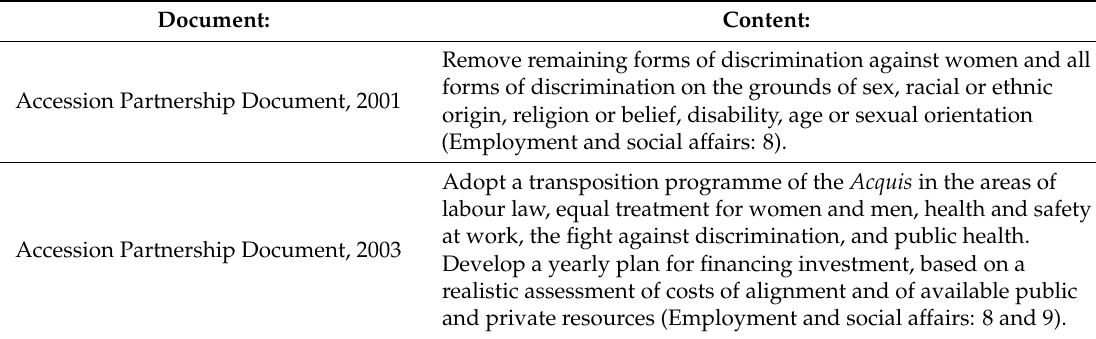
Table 1. EU requirements on